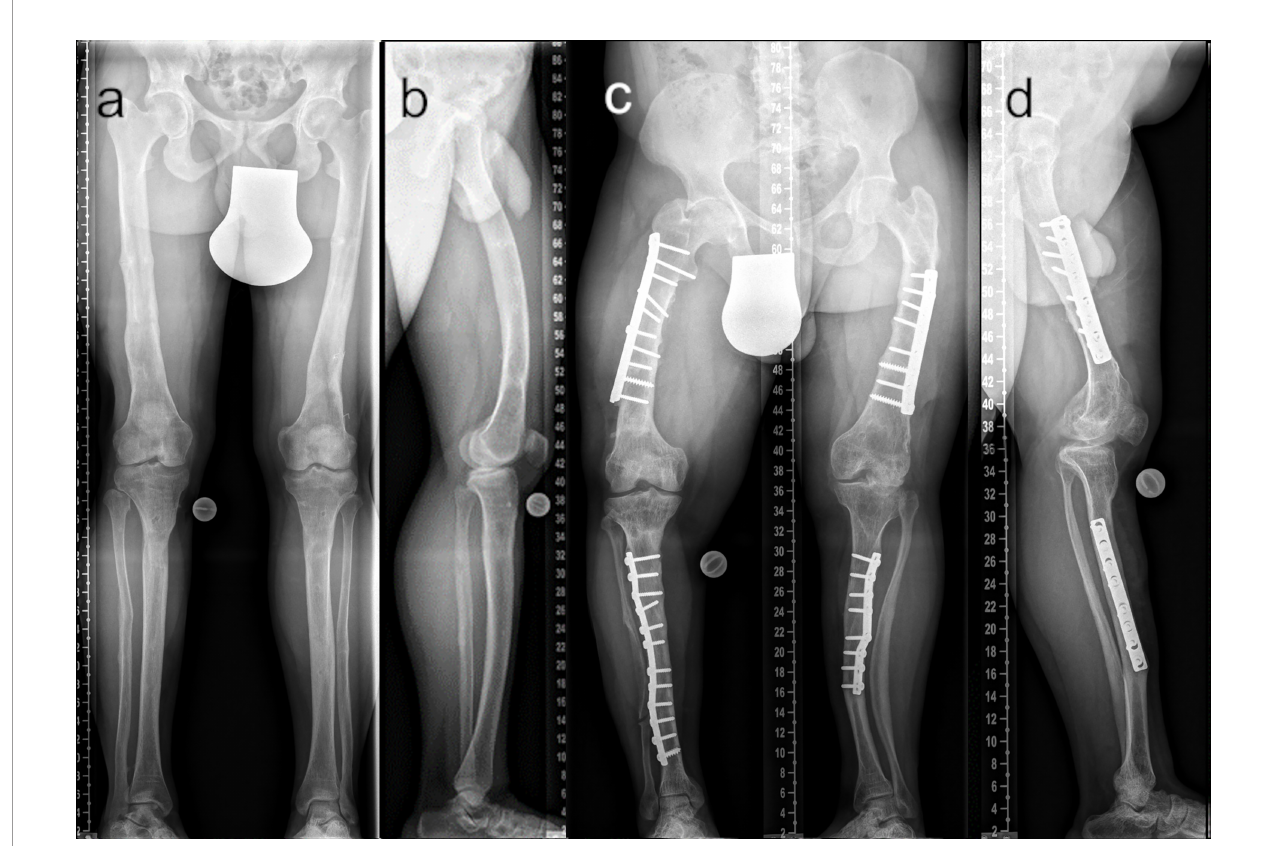
FIGURE 7 | Comparison of adequate ( A ap; B lateral) and insuf fi cient ( C ap; D lateral) surgical frontal and sagittal plane correction. The patient depicted in (A, B) underwent multilevel lower limb correction at our hospital (28 y/o, male, GDI: 62.0, BMI: 38.3 kg/m 2 , conventional oral medication). The patient depicted in (C, D) presented with multiple prior surgeries performed elsewhere (37 y/o, male, GDI: 43.3, BMI: 33.3 kg/m 2 , conventional oral